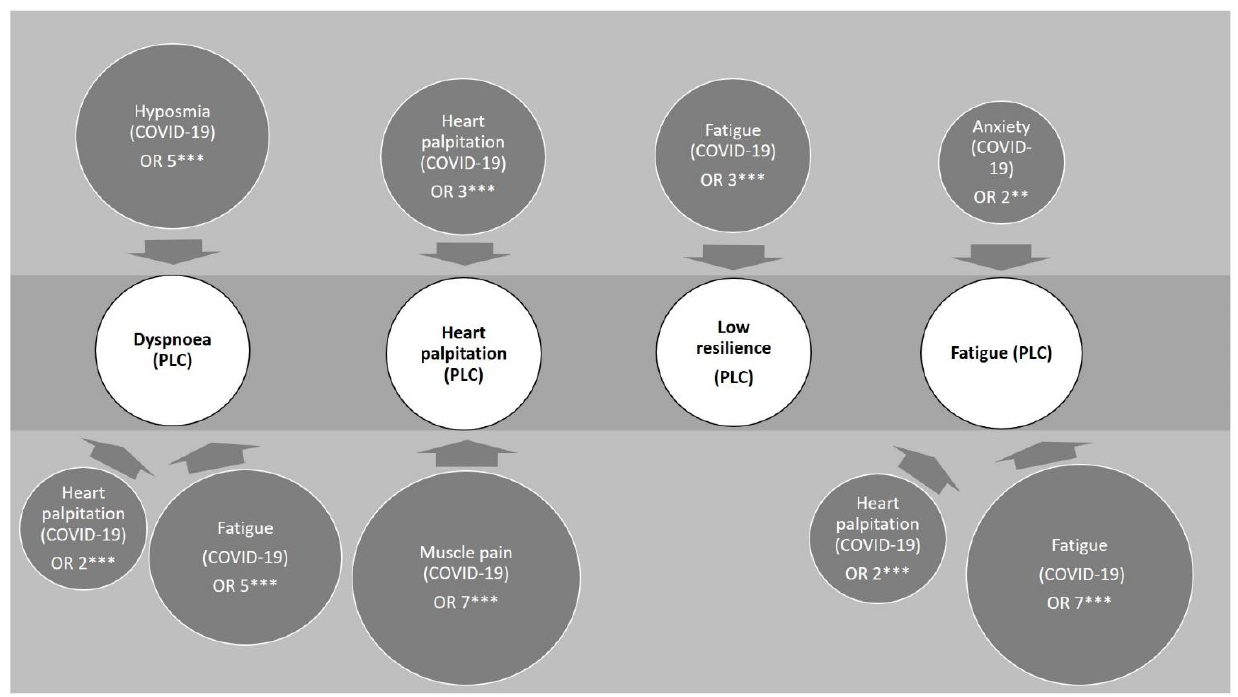
Figure 5. Flow chart for the association between self-reported COVID-19 symptoms (dark grey circles) and PLC symptoms (white circles). The number in the dark grey circles represents the probability (OR) of developing the relevant PLC symptom, the stars represent the statistical significance; OR, odds ratio, calculated from adjusted multivariable logistic regression analysis. ** p < 0.01; *** p < 0.005.